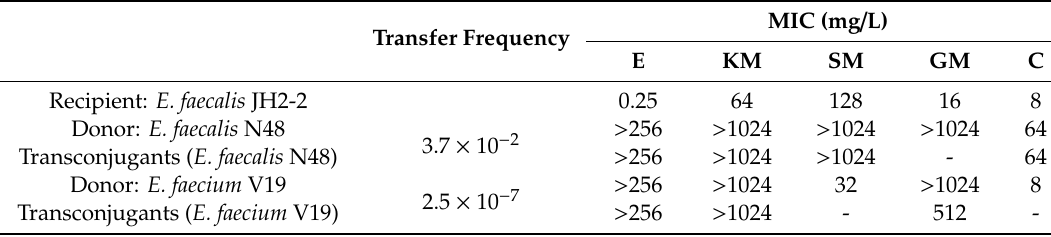
Table 3. Transfer of drug resistance in filter